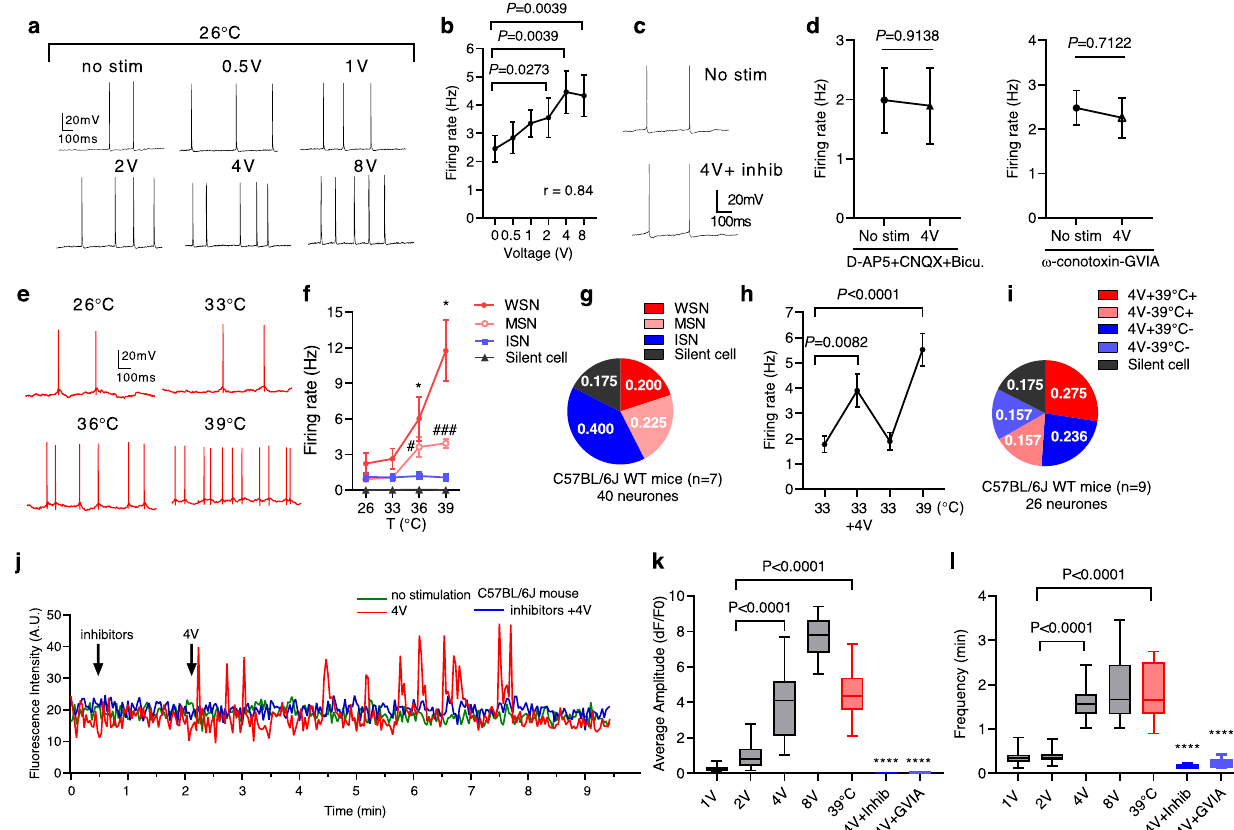
Fig. 6 | DBS activated warm sensitive neurones (WSNs) in the MPN. a Traces of stimulations (RM-1ANOVA with Dunnett ’ s post hoc test, F (1.528, 19.86) =26.56, P <0.0001; n =26 cells from 9 mice). i The proportions of POA neurones action potential(AP) fi ringinducedby HFS ofthe POA neurones. b AP fi ringrates inthePOAofC57BL/6Jmicebrainslices(two-tailedWilcoxontest, n =9cellsfrom responded to 4V HFS and/or thermal stimulation. j Wild-type mouse brain slices 4 mice). c , d A cocktail of synaptic blockers containing D-AP-5, CNQX, and bicu- calcium transients without HFS (green line), with 4V HFS (red line), and with a culline ( c and d leftpanel: unpairedtwo-tailedt test,t(14)=0.1102, P >0.05, n =8 cocktail of synaptic blockers (black line). Quanti fi cation of the average ca l cium cells from 3 mice), and ω -conotoxin-GVIA ( d right panel: t(40)=0.3716, P >0.05, transientamplitude (dF/F0)( k )andcalciumtransientspikefrequency(min)( l )in n =24 cells from 4 mice) eliminated AP fi ring in response to 4V HFS. e Traces of response to HFS and in the presence of the cocktail of synaptic inhibitors (inhib) AP fi ring e voked by thermal stimulations of the MPN neurones. f MPN neuronal or ω -conotoxin (GVIA). Box plots indicate median (middle line), 25th, 75th per- type based on AP fi ring rate and TC. RM-2ANOVA with Tukey ’ s multiple com- centile (box) and the maximum and minimum values as the whiskers. 1ANOVA parisons test was performed with * indicating WSNs P (39°C vs. 26°C) =0.0132 and with Tukey ’ s post hoc test; **** P <0.0001 compared with the 4V group for ( k , l ). P P n =20cellsfrom5mice.Alldataweremea n ±s.e.m.Sourcedataareprovidedasa (36°C vs. 26°C) =0.039 6 , # indicating MSNs (36°C vs. 26°C) =0.0489, and ### for n =40 cells from 7 mice. g POA cell categories based on P Source Data fi (39°C vs. 26°C) =0.0003. theirTC. h NeuronalAP fi ringrateevokedbyasequenceofthermalandelectrical